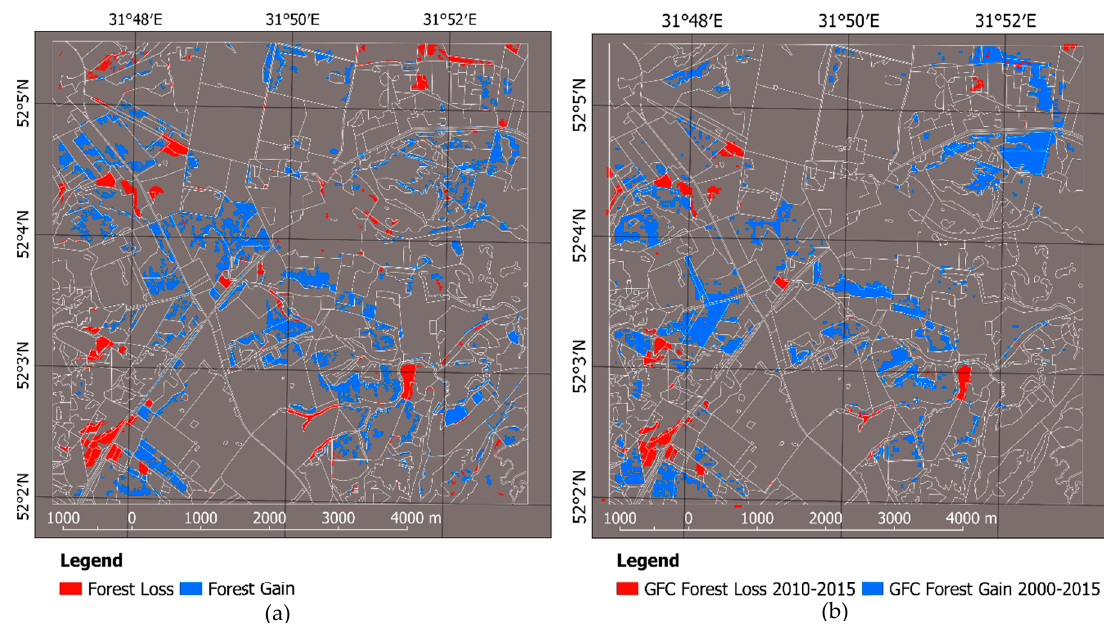
Figure 8. Mapping forest change within the study area using ( a ) RapidEye versus SPOT 6 classification and ( b ) Global Forest Change data [36].